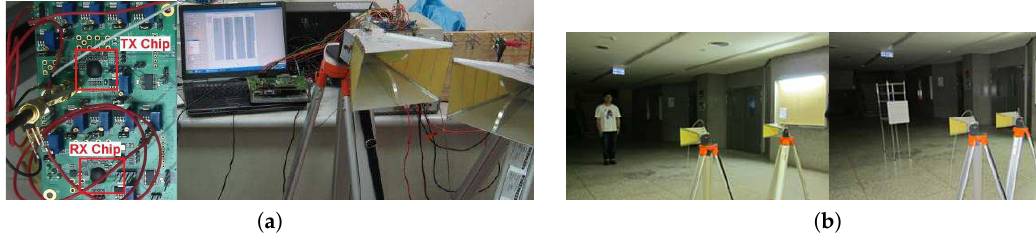
Figure 2. ( a ) The complementary metal-oxide-semiconductor (CMOS) radar system [10] and ( b ) measurement environments.